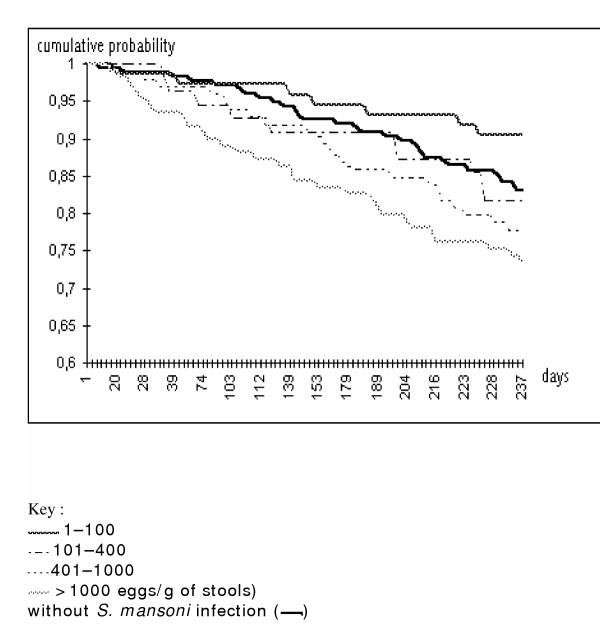
Probability of not having had a malaria attack in children presenting S. mansoni infection or without S. mansoni infection